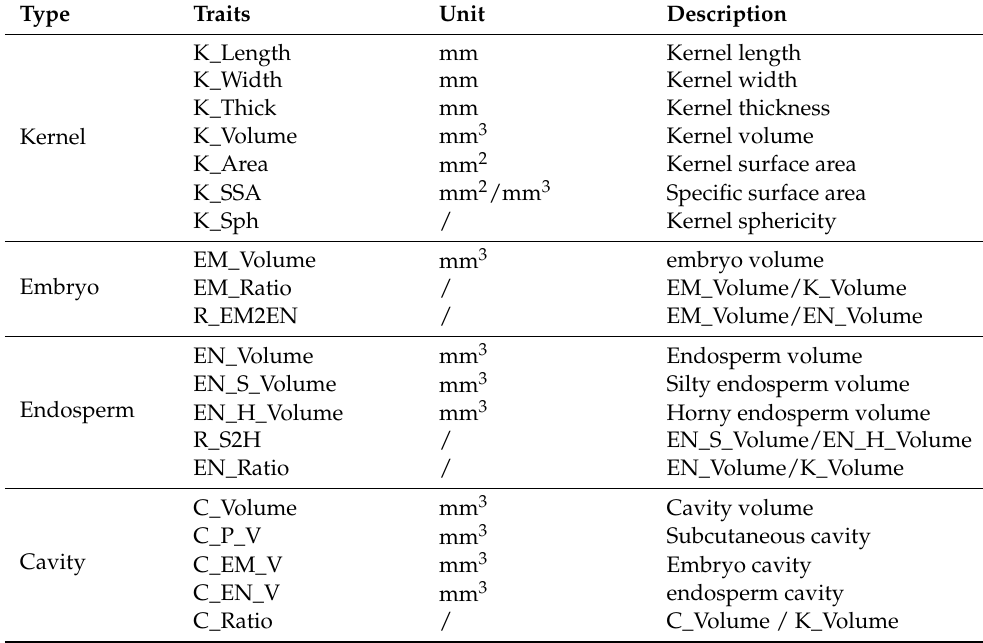
Table 1. The description of maize kernel traits in this